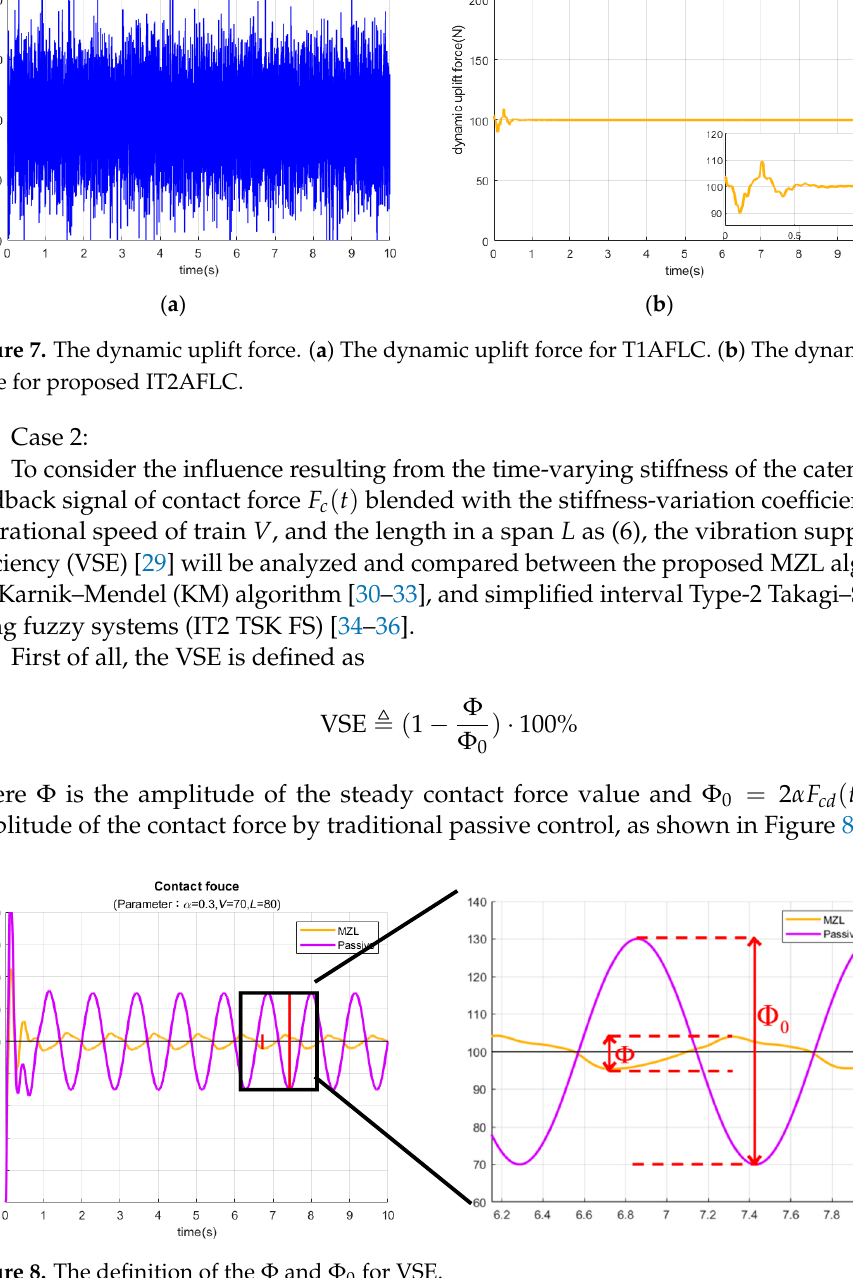
Φ for VSE. Φ for VSE.